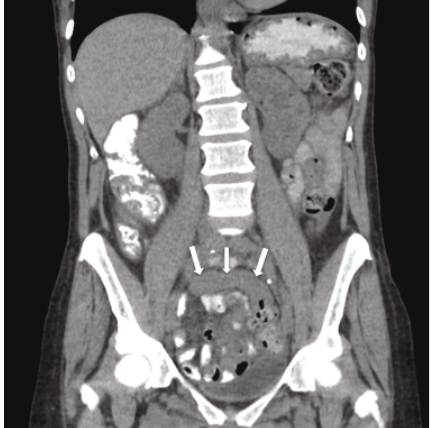
Figure 2: Rectosigmoid colonic wall thickening again demonstrated with white arrows at the site of